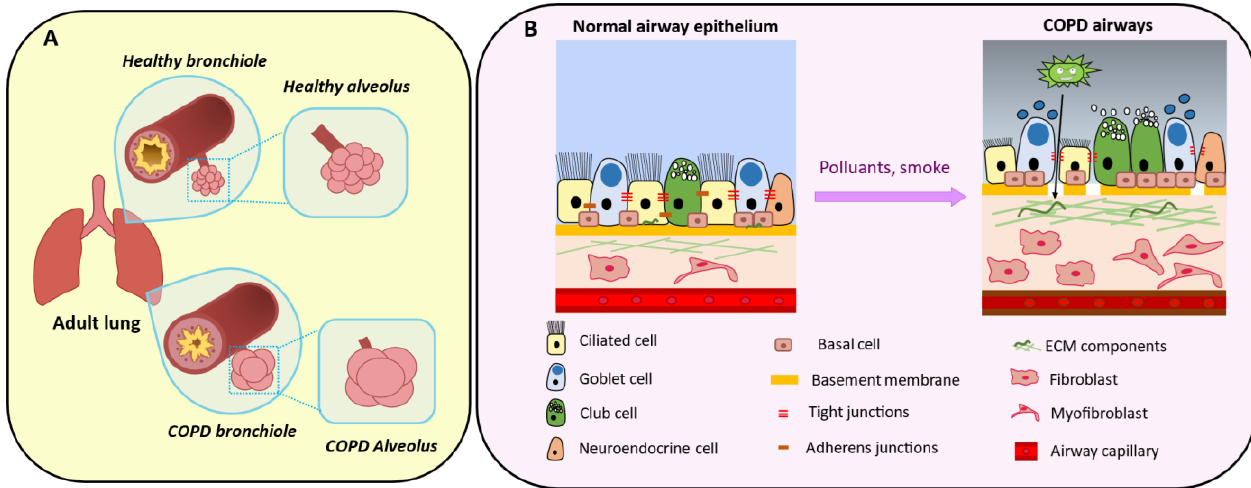
Figure 5. Aspects of COPD development. ( A ) ( Top panel ) Healthy bronchioles present a thin wall and a lumen where mucus is secreted to externalize pathogens. Alveoli contain elastin fibers and regulate gas exchanges between lung and blood. ( Bottom panel ) Over time, chronic exposure to tobacco, air pollution and/or recurrent infections lead to a thickened bronchiole wall associated with airflow obstruction. Emphysema is caused by gas trapping that damages the alveoli, followed by progressive peribronchiolar fibrosis. ( B ) ( Right panel ) In the alveolar-capillary unit, epithelial cells are inter- connected and attached to the basement membrane above the mesenchymal compartment. ( Left panel ) Chronic exposure to pollutants damages ciliated cells (leading to impaired mucociliary clearance), alters the epithelial cell barrier and the basement membrane with loss of tight junctions and pathogen penetration in the lower layers. This is associated with mucus plugging and goblet cell hypersecretion. Pro-proliferative fibroblasts and myofibroblasts contribute to extracellular matrix (ECM) deposition that impairs injury